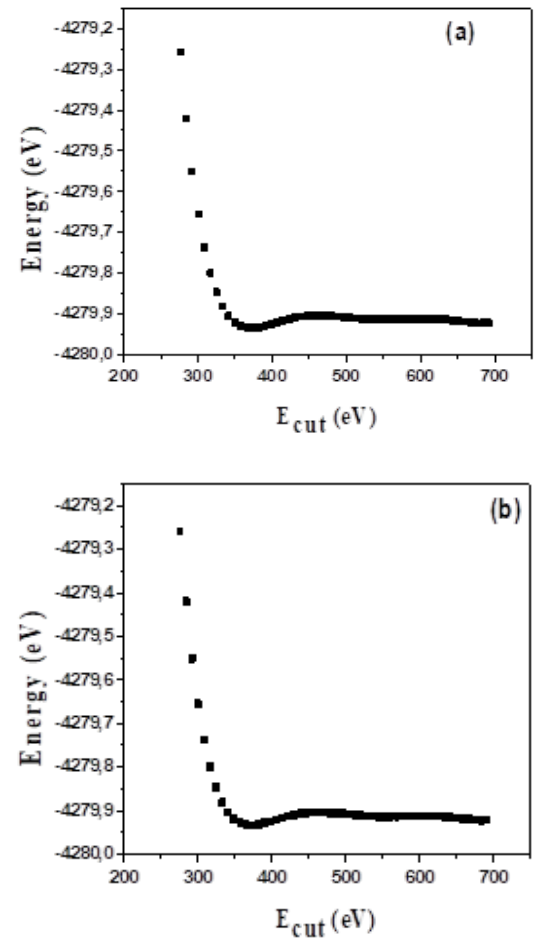
Fig. 2. Energy versus E cut in cubic (a) and hexagonal (b)